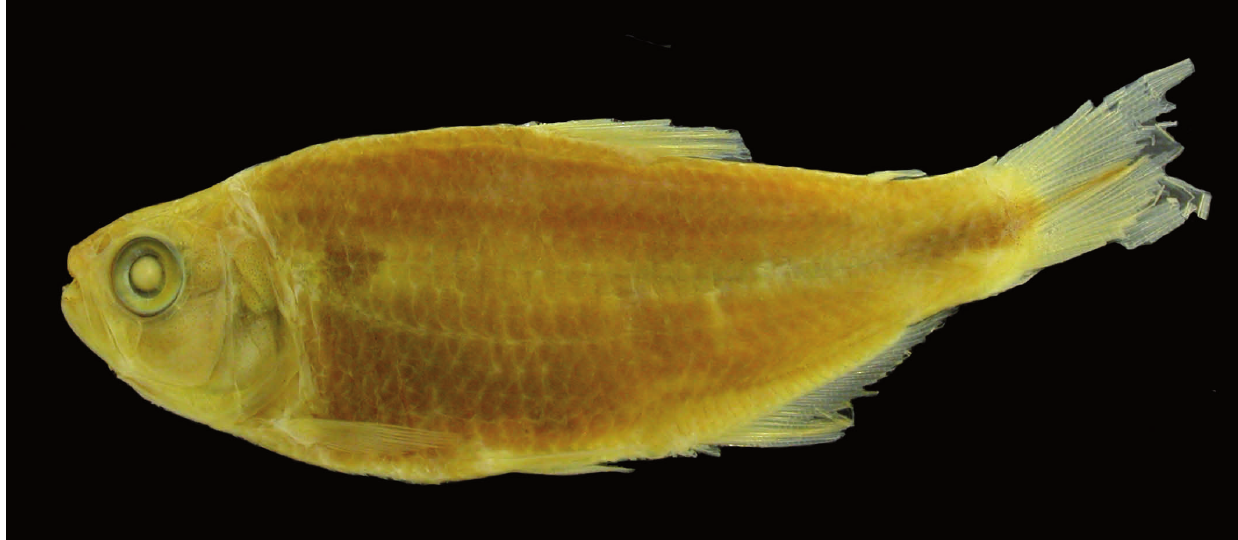
Fig. 6. Astyanax laticeps , ANSP 21852, holotype, 54.1 mm SL, Rio Grande do Sul, Brazil.